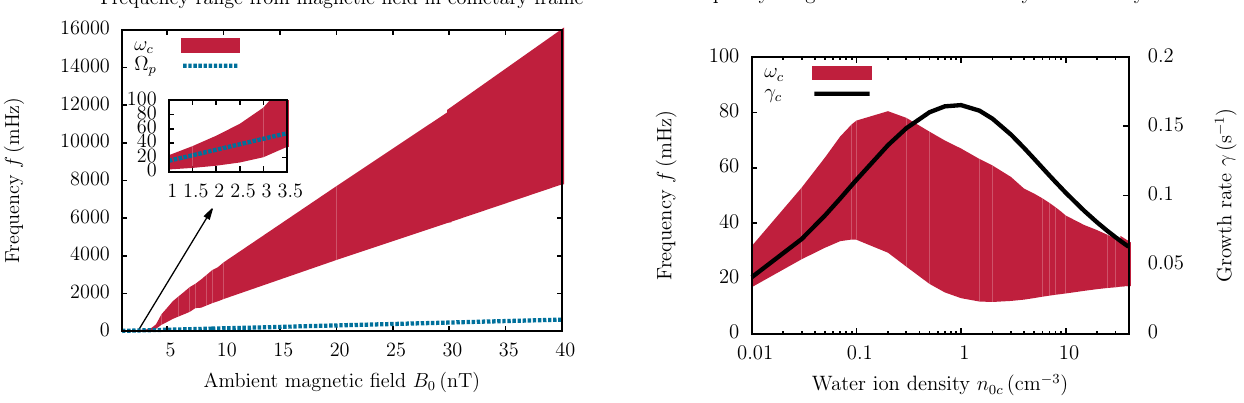
Figure 11. Variation of the frequency range of ω 0 regarding the water ion density n 0c analogous to Fig. 10.